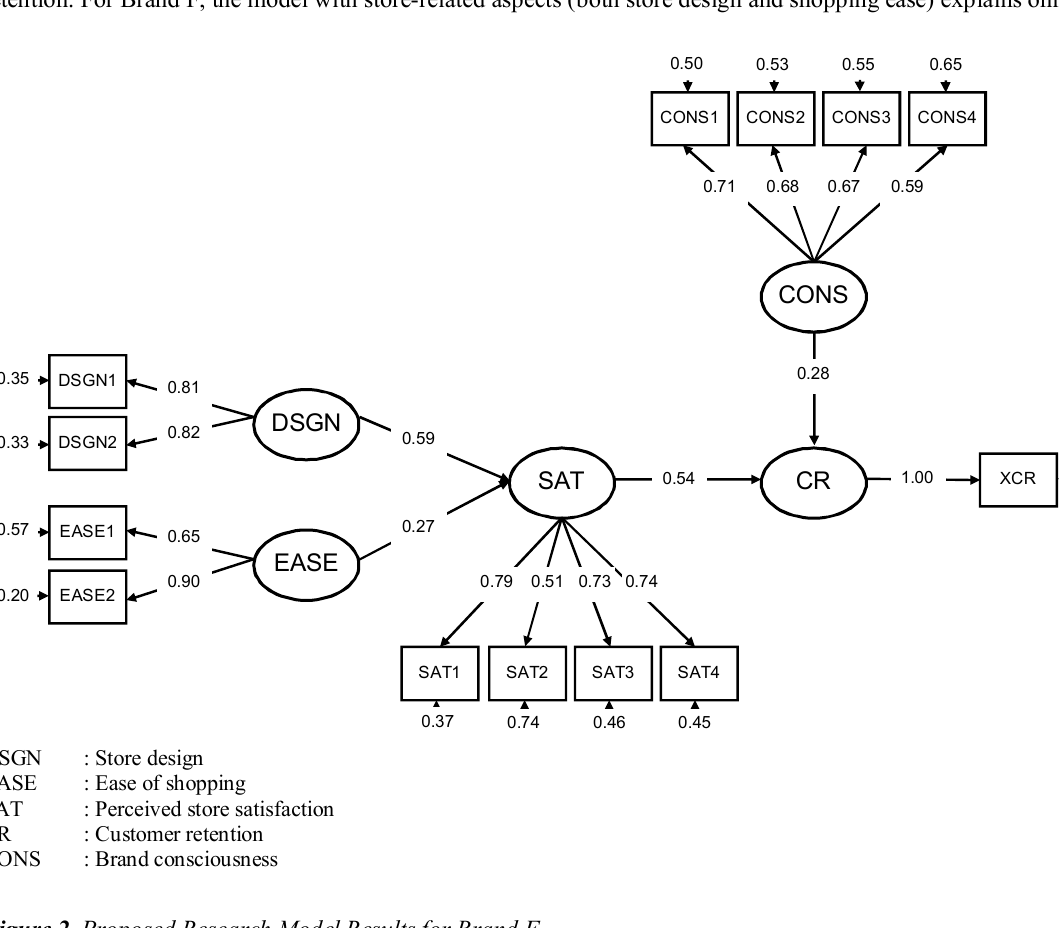
Figure 2. Proposed Research Model Results for Brand